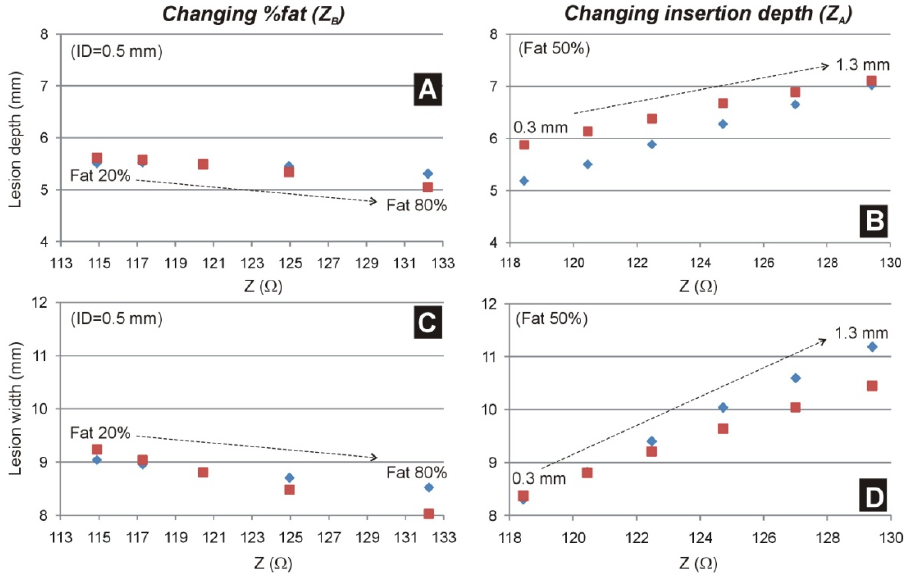
Figure 7. Lesion depth ( A , B ) and maximum width ( C , D ) computed for different baseline impedances with (blue marks) and without (red marks) ‘corrected’ power. While in ( A , C ) the scatter in baseline impedance is due to the percentage of fat in tissue rounded the heart ranging from 20 to 80% (i.e., changing Z B ), in ( B , D ) the scatter in baseline impedance is due to the insertion depth of the electrode ranging from 0.3 to 1.3 mm (i.e., changing Z A